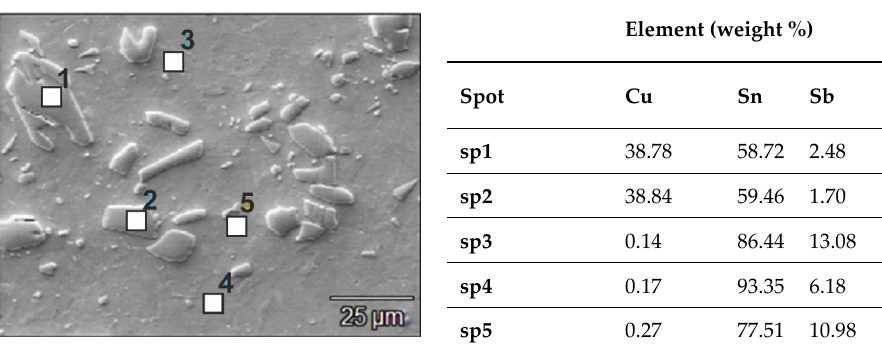
Figure 7. Microstructure of B89 alloy after FSP modification at 280 RPM and results of EDS chemical composition spot analysis; SEM.